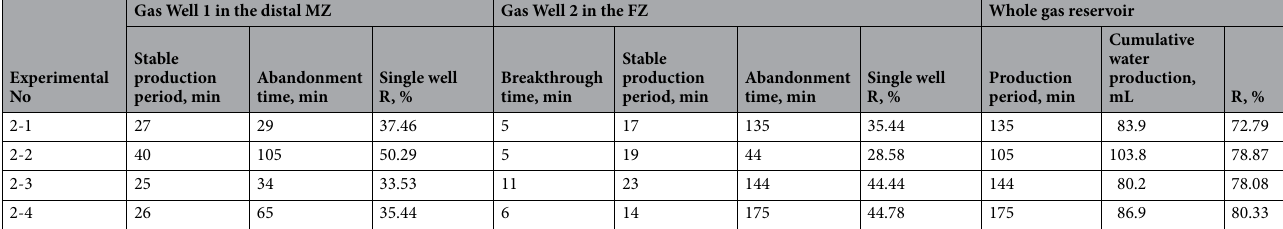
Table 6. Statistics on the production of Group II.